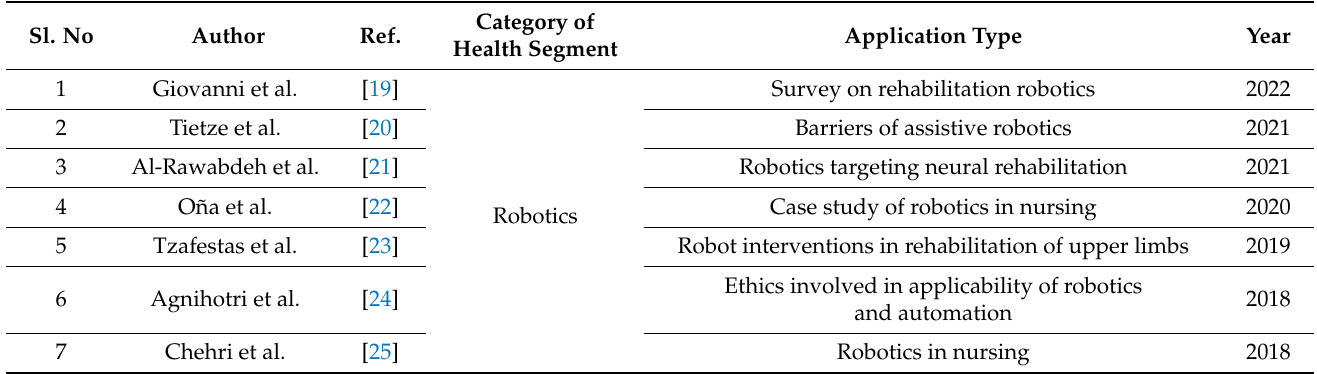
Table 1. Review of applicability of robotics.